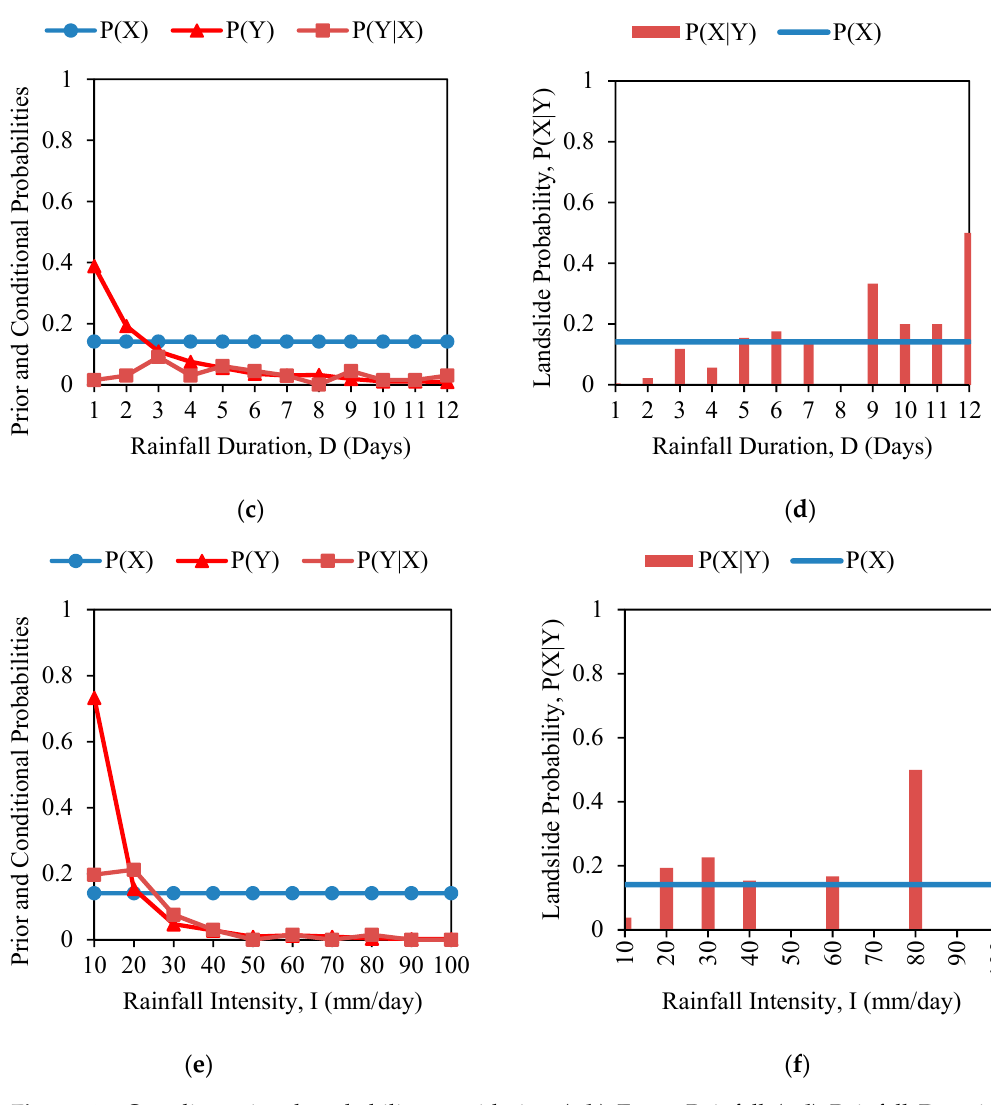
Figure 4. One-dimensional probability considering ( a , b ) Event Rainfall ( c , d ) Rainfall Duration ( e , f ) Rainfall Intensity for Chukha region.